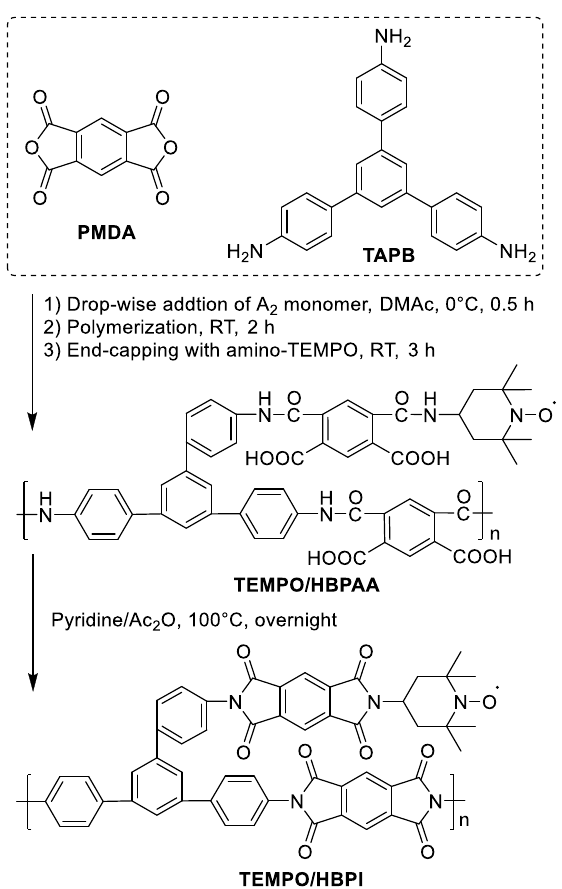
Scheme 6. Synthesis of hyperbranched polyimide modified with TEMPO